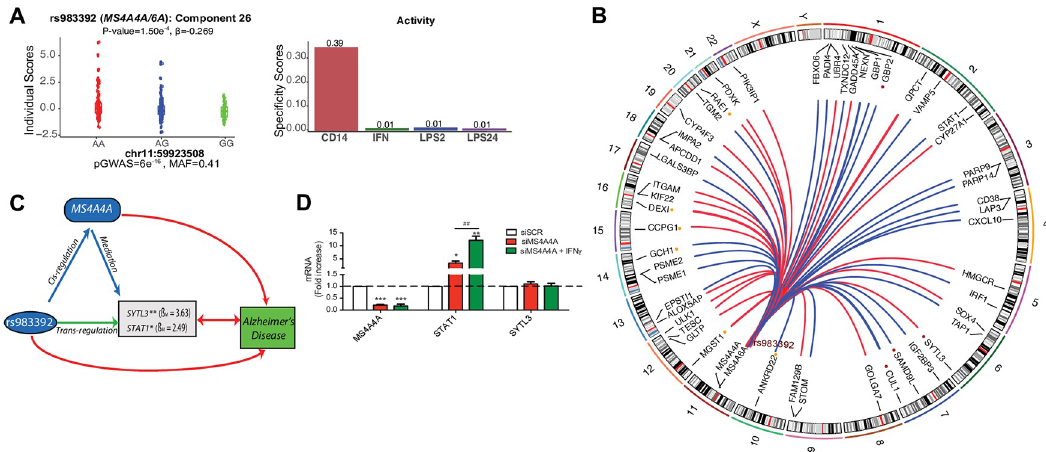
Fig 5. Trans -eQTL colocalized in Alzheimer’s disease associated MS4A locus. (A) The genotypes for Alzheimer’s disease susceptibility allele rs983392 are significantly associated with the individual scores of component 26. rs983392 is trans -eQTL to FF component 26 with 54 genes (left panel). The component 26 is active only at baseline (right panel). (B) Circular plot demonstrating the chromosomal position of trans -eSNP (rs983392) and the 54 trans target genes. The minor and AD-protective allele rs983392-G is associated with decreased (blue lines) and increased (red lines) expression of trans -eGenes. The colored dots are trans -eQTL that replicates in ImmVar baseline monocytes (red and yellow color dots denote trans -eQTL association at FDR < 0.05 and 0.20, respectively). Only the trans -eGenes with PIP > 0.5 and 2.5% distributional cut-off are shown. (C) Alzheimer’s disease SNP rs983392 mediates trans -effects to two trans -eGenes through cis -mediator MS4A4A . (D) Experimental validation using THP-1